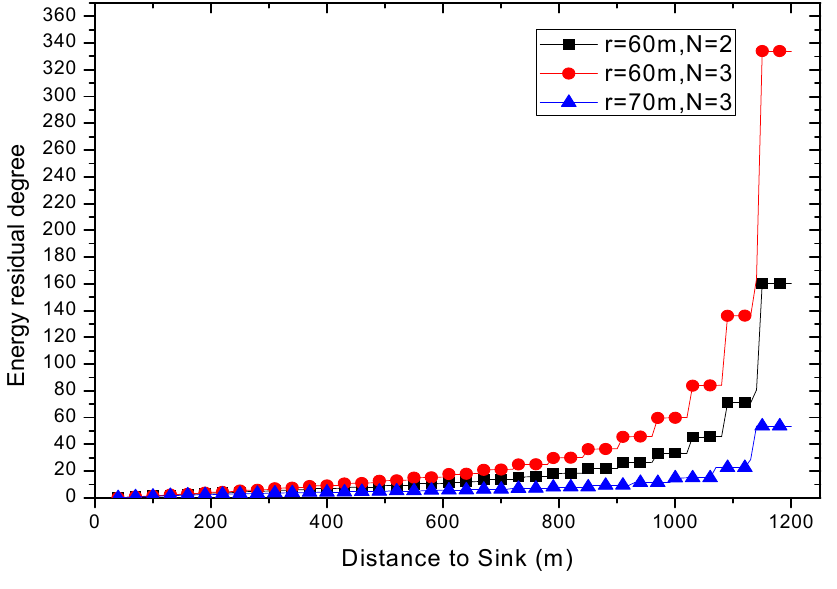
Figure 13. Energy residual degree of node at different distance.